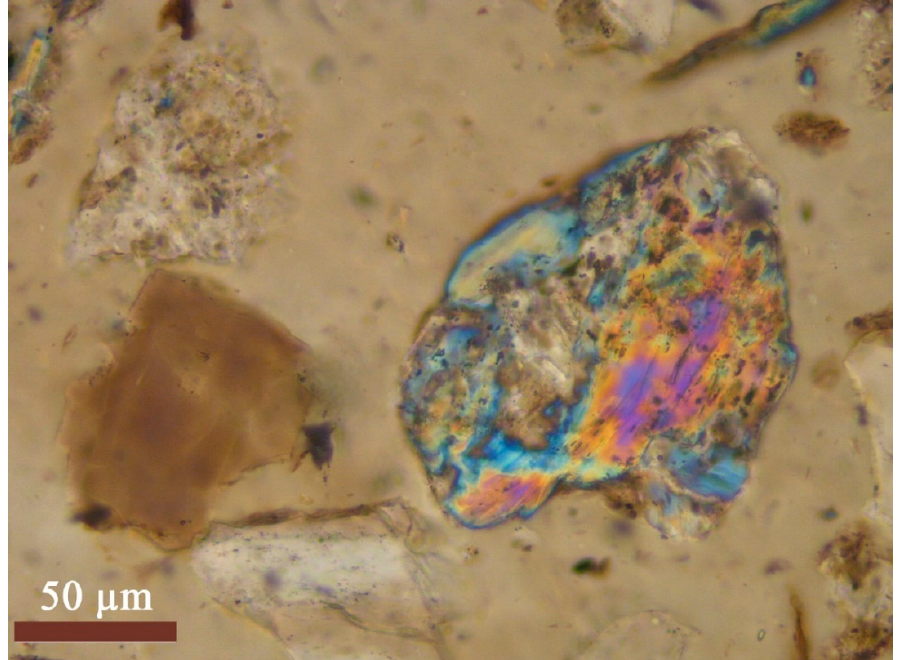
Figure 8. Muscovite, third terraces of Samoylov Island. (S 1 − 6). Plane polarized light.